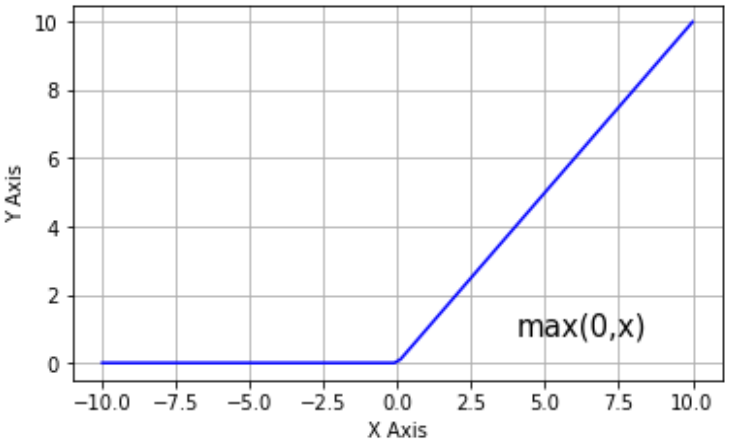
Figure 18. Graphical Representation of Generic ReLU Activation Function.